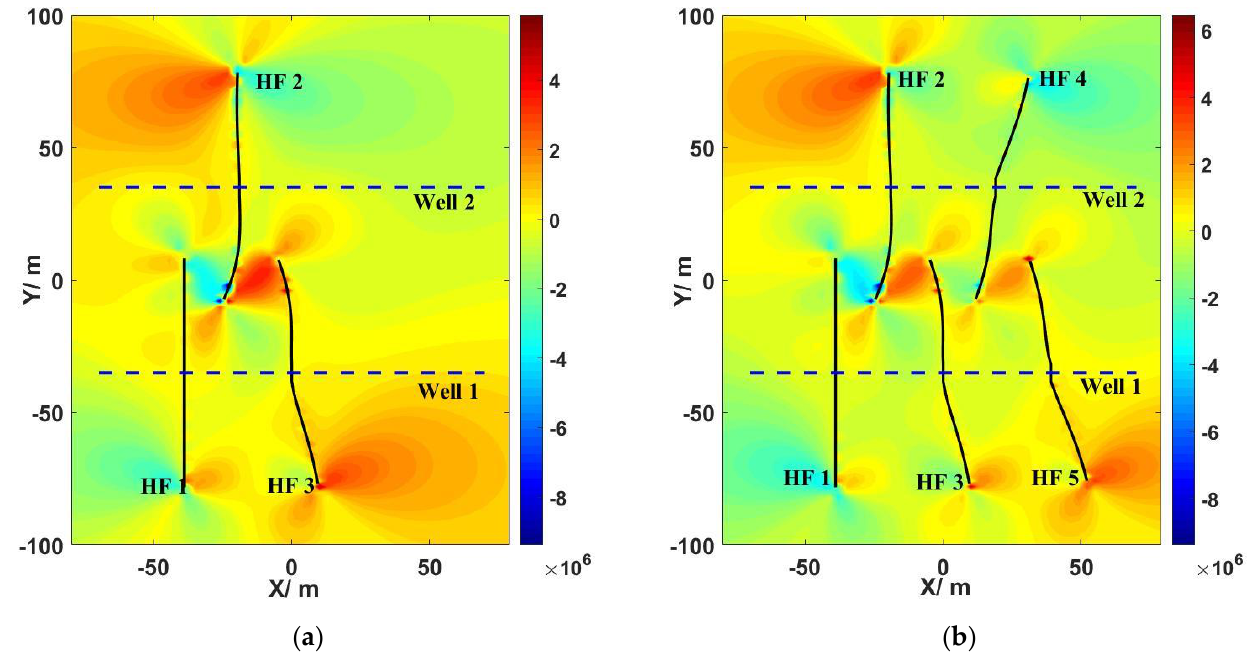
Figure 9. Numerical simulation results of fracture morphology and induced stress of ( a ) σ xx produced by residual aperture after completion of fracturing; ( b ) σ xy produced by residual aperture.